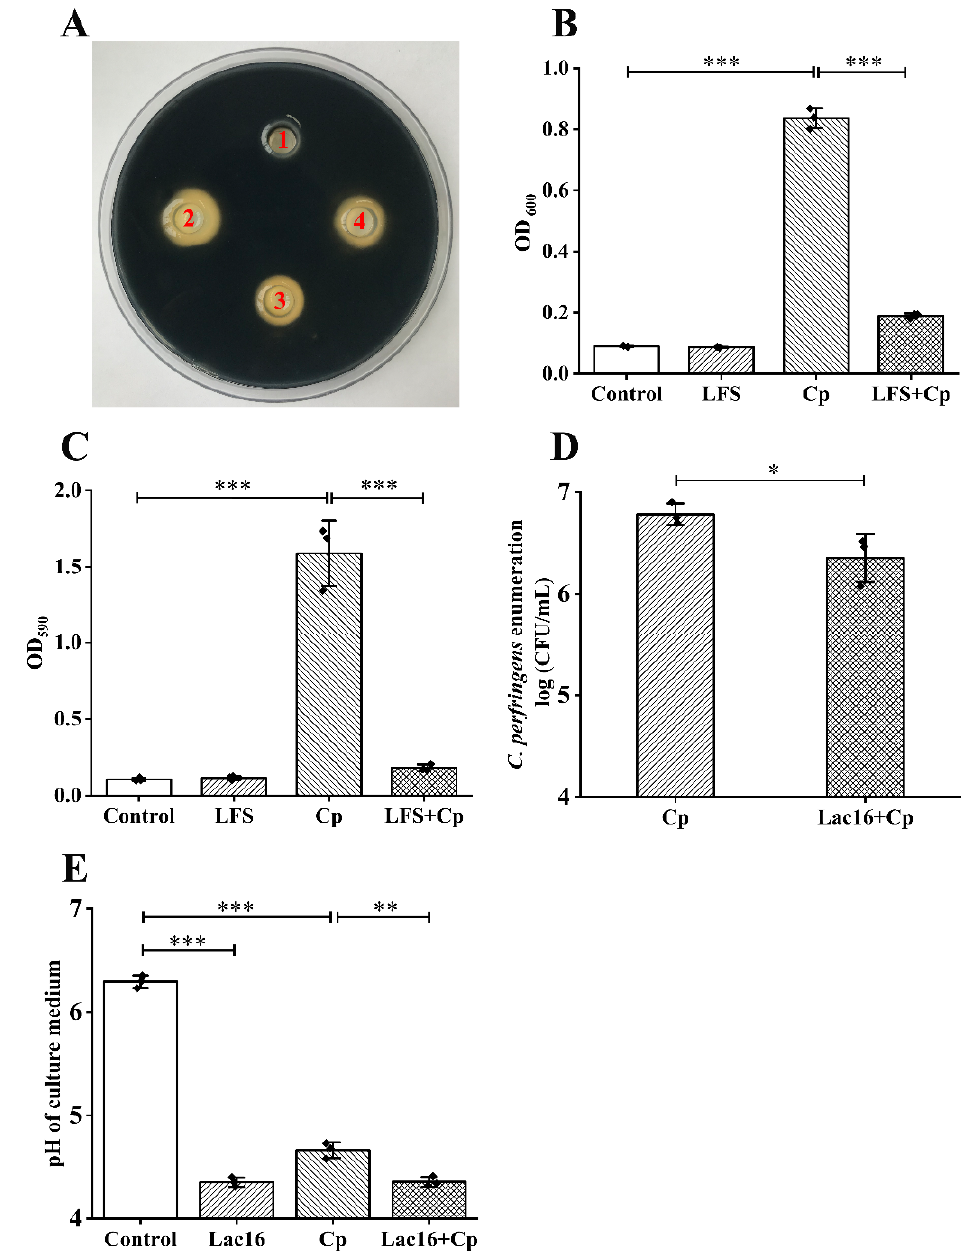
Figure 1. Antimicrobial activity of L. plantarum Lac16 on C. perfringens . ( A ) Agar well diffusion as-